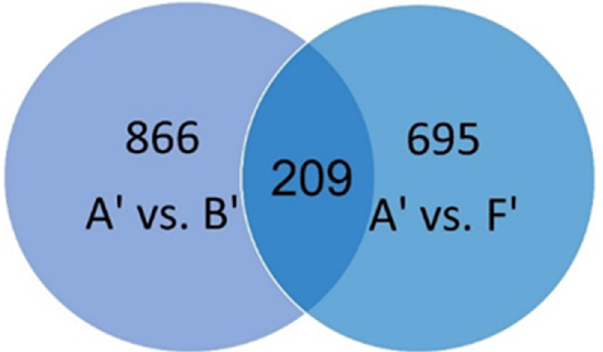
Figure 2. Venn diagram showing the relationships between DEG groups after comparisons of A’ vs. B’ and A’ vs. F’ after a sharp cutoff (FDR-adjusted p value < 0.05 and 2.0 ≤ Log 2 FC ≤ −